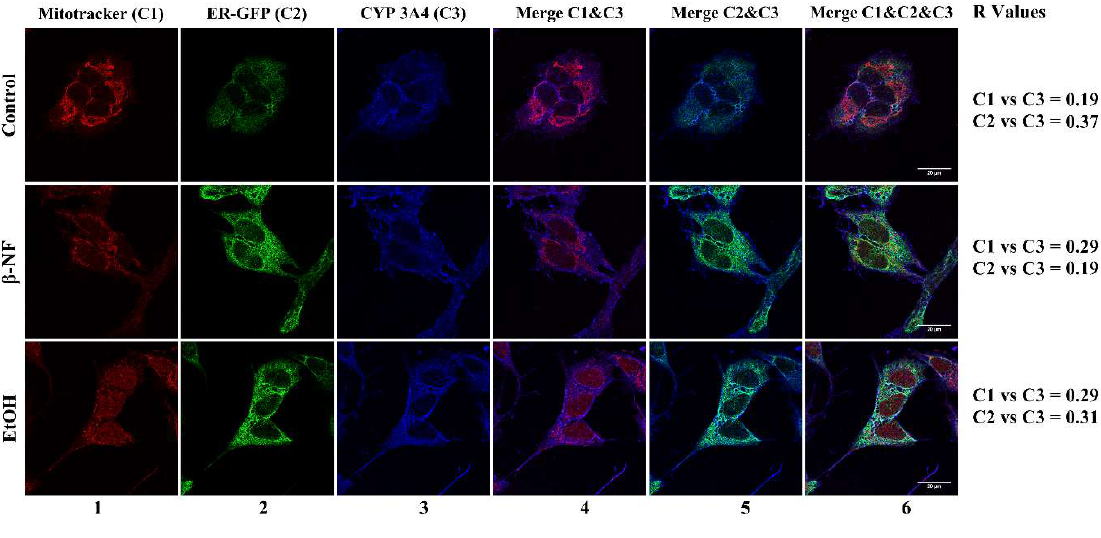
Figure 7. Immunostaining of CYP3A4 in SH-SY5Y cells after β -NF and EtOH treatment. Representative immunofluorescence images of each experimental condition. Column 1 represents mitochondrial stain (red), column 2 represents ER-Green Fluorescent Protein (GFP) stain (green), and column 3 reports the CYP3A4 staining (blue). Column 4 represents the merge between CYP3A4 and mitochondria channel, column 5 represents the merge between CYP3A4 and ER-GFP, and column 6 represents the merge of the three channels. R Values: Pearson’s correlation coefficient. Scale bar: 20 µm.